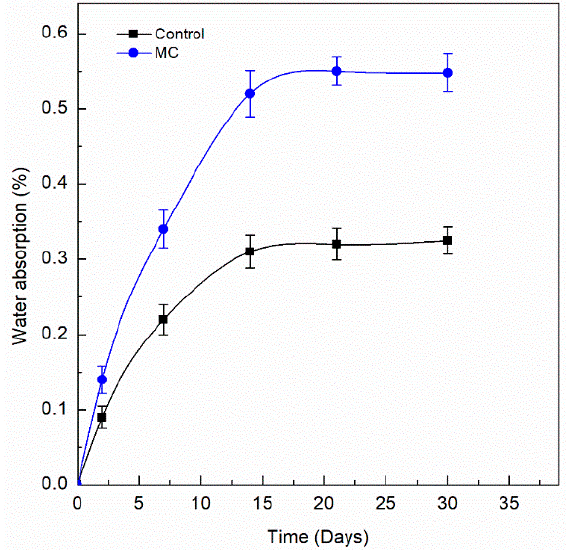
Figure 4. The water uptake of coatings with microcapsules (MC) and without microcapsules (control) on carbon steel plates measured by gravimetric analysis. Error bars represent the standard de- viation.